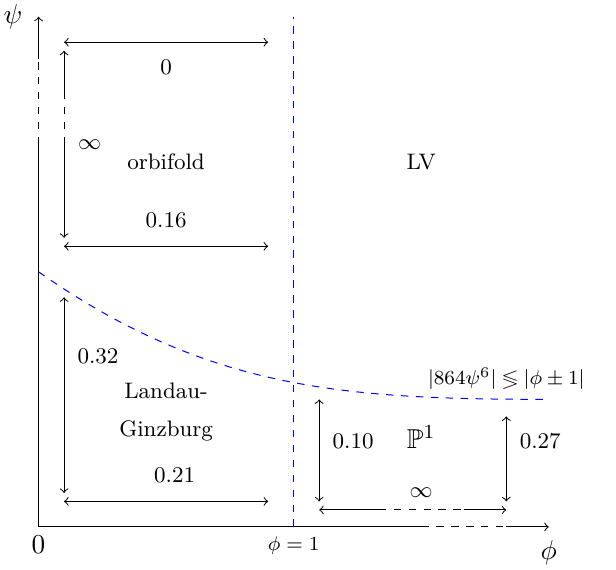
[12] with indicated finite and infinite 11226